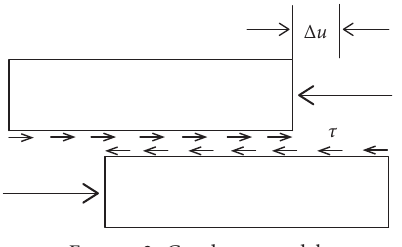
Figure 2: Goodman